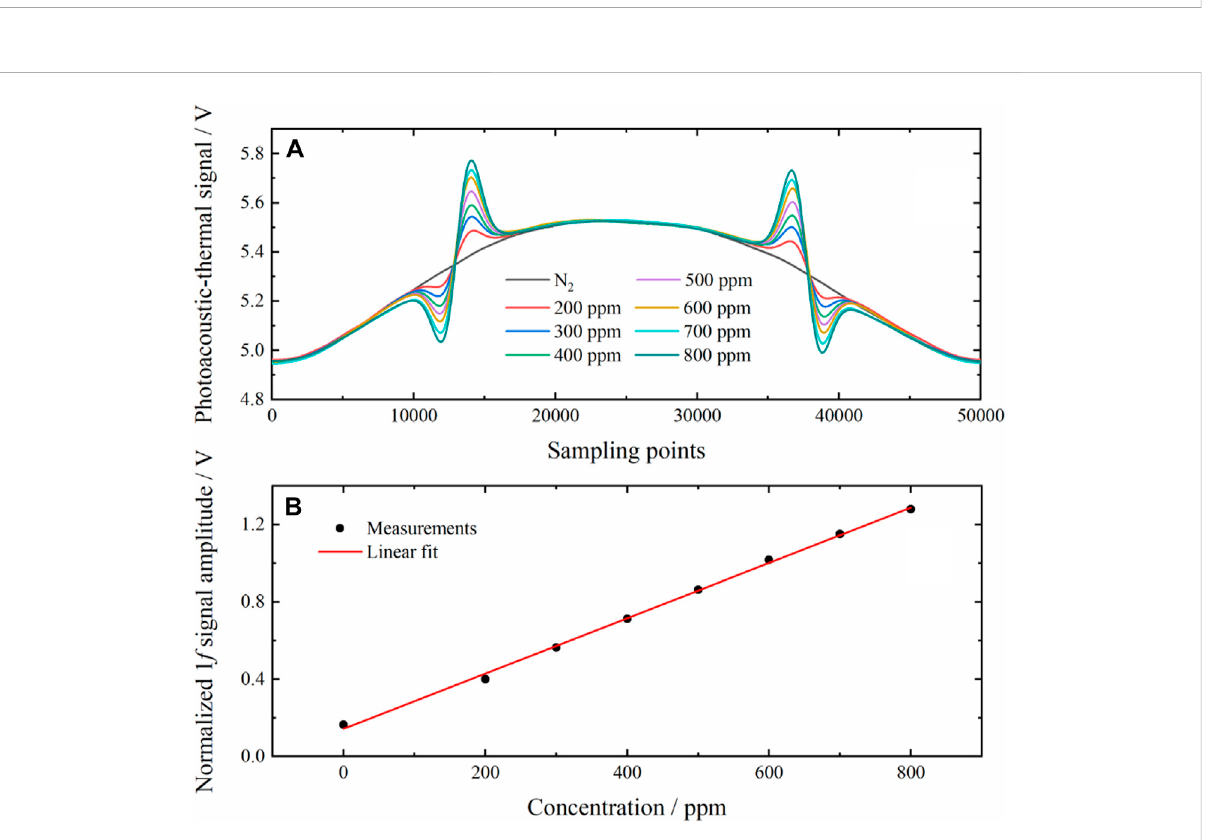
change of the photothermal-acoustic signal induced by varying light intensity can be corrected accurately with the photothermal baseline. The maximum deviation of the normalized peak-to-peak amplitude is within 0.7% under different light intensity from 4.03 mW to 16.82 mW.